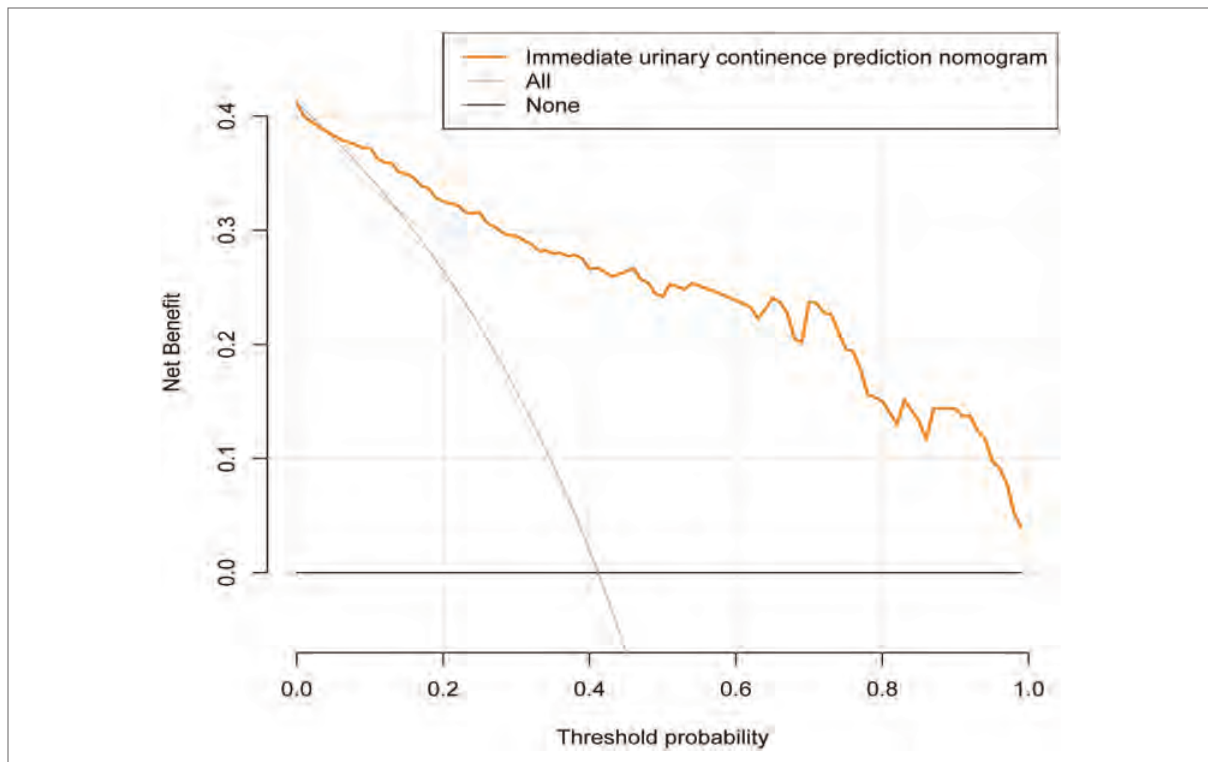
FIGURE 8 Decision curve analysis for the immediate urinary continence recovery nomogram. Notes: The y -axis measures the net bene fi t. The dotted line represents the immediate urinary continence nomogram. The thin solid line represents the assumption that all patients achieving the recovery of immediate urinary continence. Thin thick solid line represents the assumption that no patients are immediate urinary continence. The decision curve showed that if the threshold probability of a patient is 1% using this nomogram in the current study to predict immediate urinary continence possibility adds more bene fi t than the intervention-all-patients scheme or the intervention-none